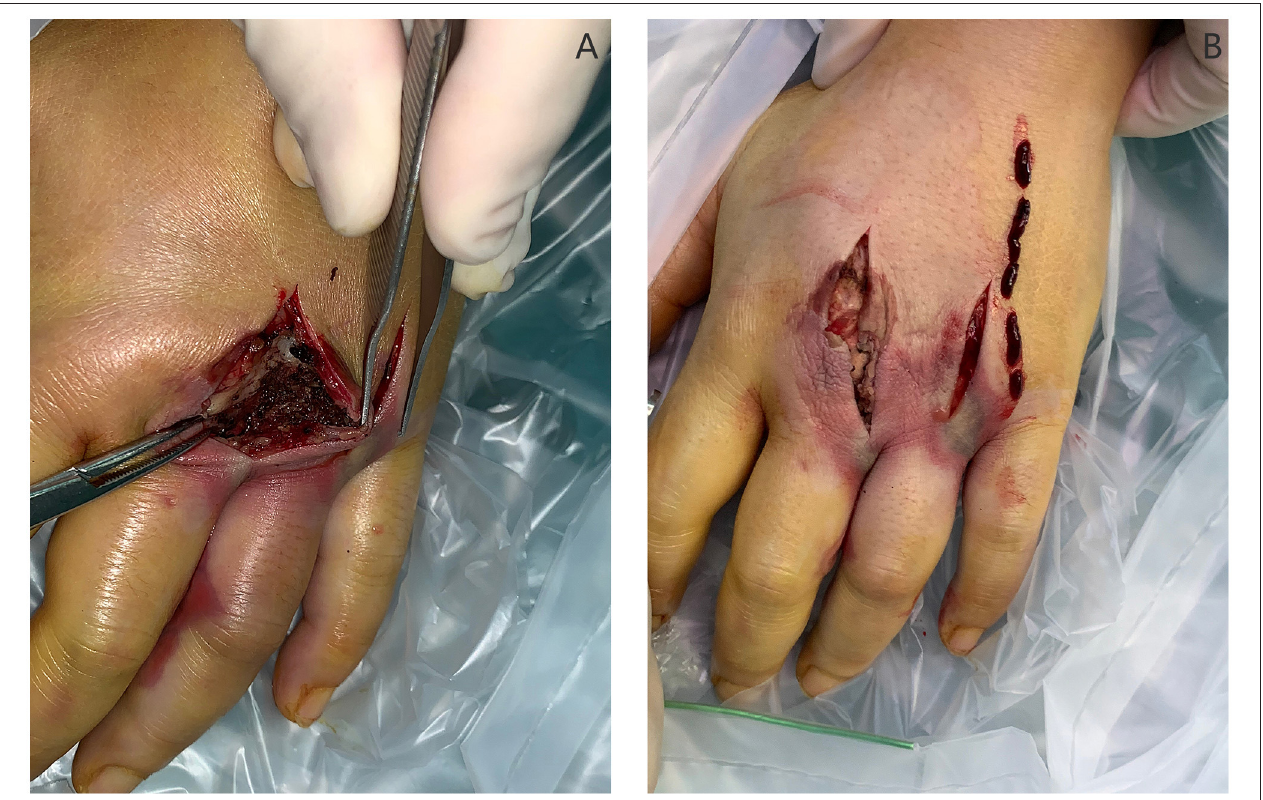
FIGURE 2 | Debridement on the dorsal side: (A) Black “carbonized” tissue throughout the entry wound with the pathological report: small pieces of fiber, fat, nerve, and vascular tissue with bleeding. (B) Ten centimeters of thrombus removed from the digital dorsal vein.